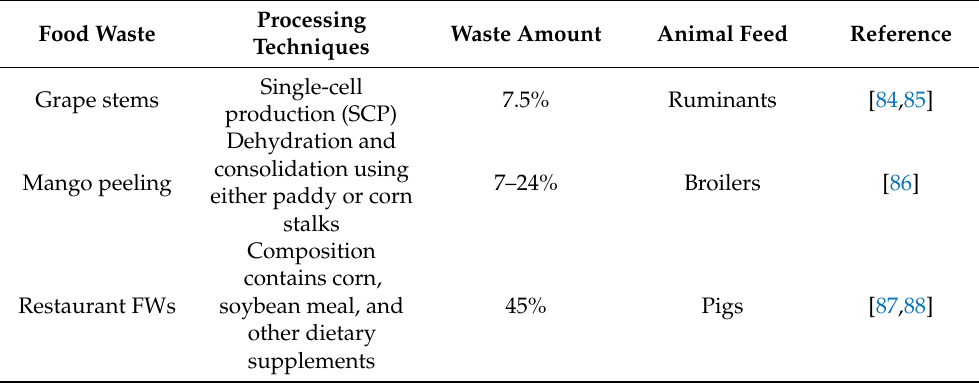
Table 2. Techniques of analyzing different FWs and their use as animal